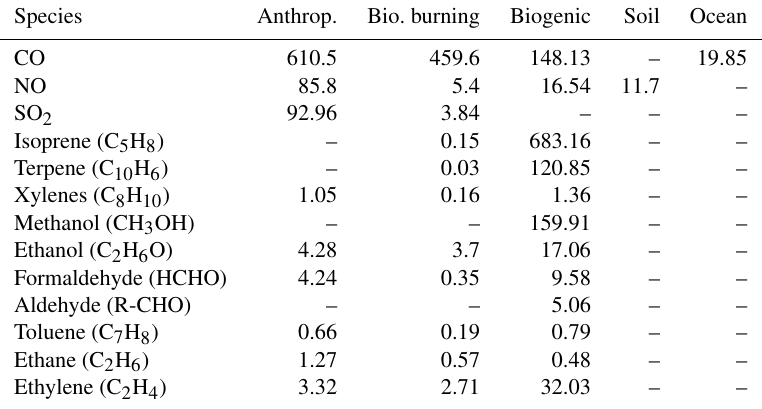
Table 2. Emission totals by category in Tg(species)year − 1 for 2004. Anthropogenic and biomass burning emissions applied in this study are based on Lamarque et al. (2013). Ocean and soil natural emissions are based on the POET global inventory (Granier et al., 2005). Biogenic emissions are computed online from MEGAN (Guenther et al.,